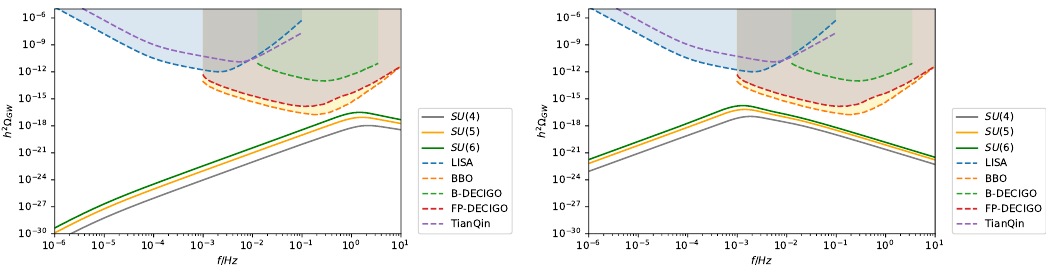
Figure 6 . GW signals from the 4-6 PLM for N = 4 , 5 , 6 with T c = 100 GeV (left panel) and T c = 100 MeV (right panel). The SM contribution has been set as ζ = 1 . The signals with N = 7 , 8 for 4 − 6 PLMs will look like nearly overlapping with the N = 6 signal in this plot, because of almost degenerate ˜ β s as read off from table 2.